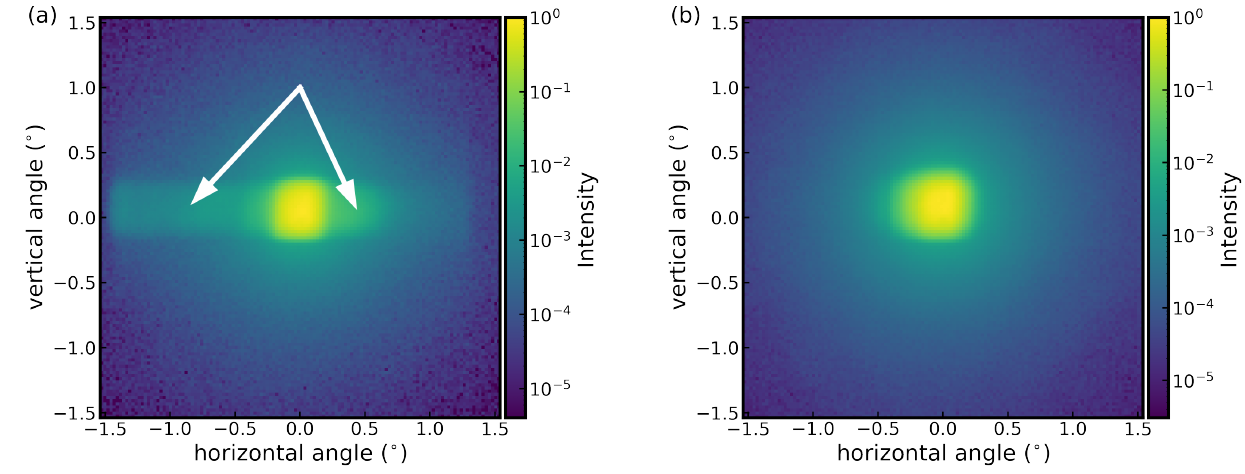
Figure 5. Comparison of the detector image at a wavelength of 6Å. Panel ( a ) shows the image without an additional collimator where some spurious scattering due to the specular reflected spin- up neutrons appears; panel ( b ) shows the image with an additional 20 (cid:48) horizontal and vertical collimation, giving a much cleaner beam